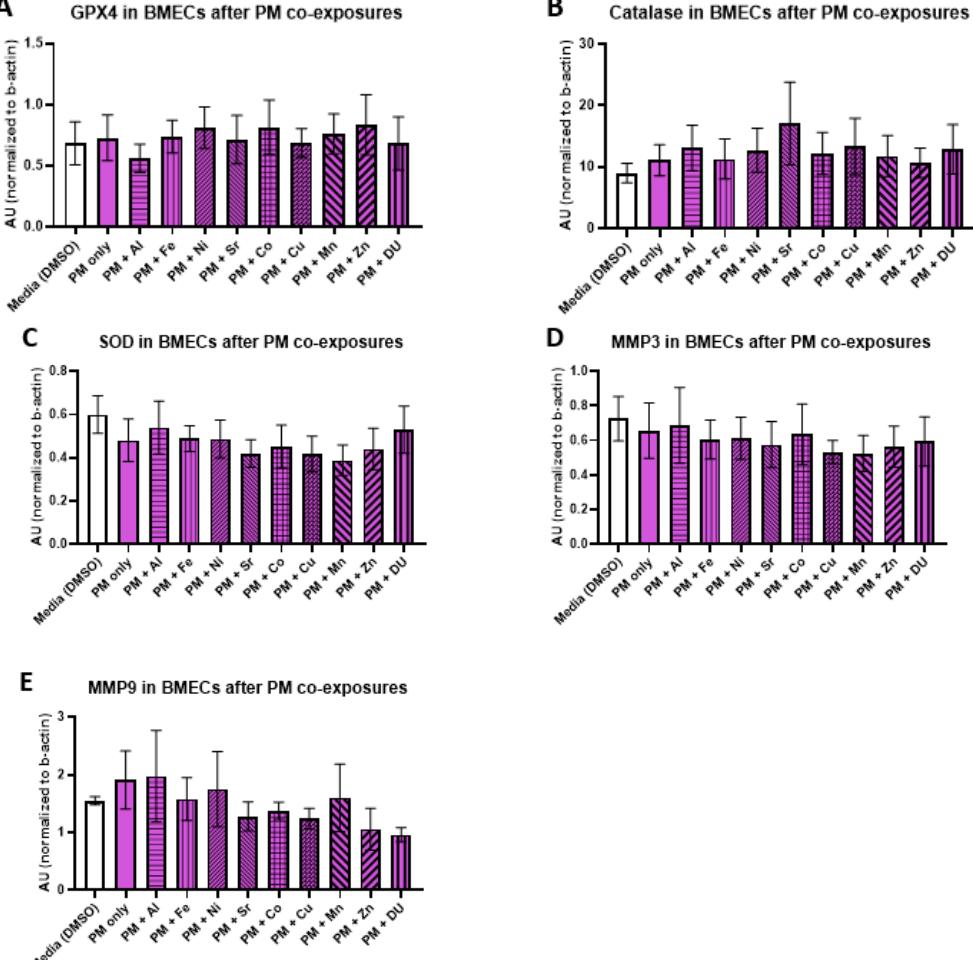
Figure 7. Oxidative stress proteins in brain microvascular endothelial cell (BMEC) cultures after permethrin (PM) and metal exposure. Assessment of several oxidative stress related protein levels in BMEC cultures after exposure to PM (10 µM) and metals (1 µM). ( A ) GPX4 expression, ( B ) catalase expression, ( C ) SOD expression, ( D ) MMP3 expression, and ( E ) MMP9 expression. All assessments are from the same experiment setup—each protein run is completed from the same homogenized sample cell pellets. PM alone is compared to media alone, and then each PM + metal group is compared to PM alone. Data represent the mean and standard deviation of three independent experiments.